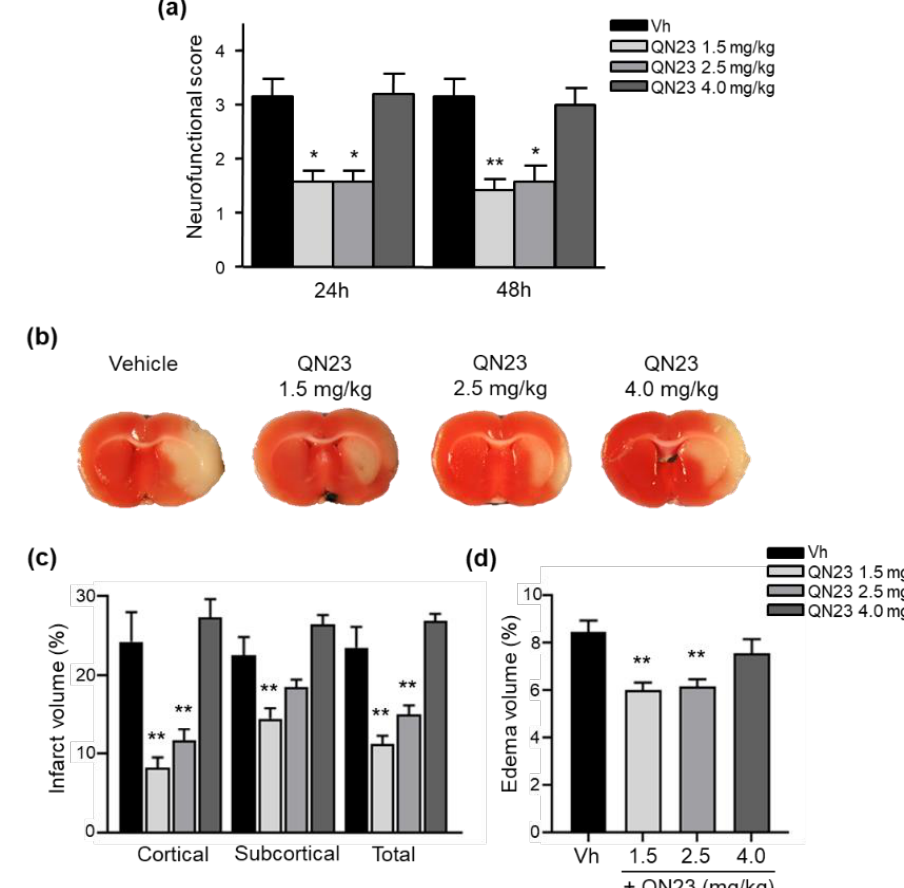
Figure 9. Cerebroprotective effects of QN23 in male Wistar rats subjected to ischemic stroke and treated with vehicle (Vh, n = 7); QN23, 1.5 mg/kg ( n = 7); QN23, 2.5 mg/kg ( n = 7); and QN23 4.0 mg/kg ( n = 5). ( a ) Neurofunctional score at 24 h and 48 h after tMCAO (transient middle cerebral artery occlusion). ( b ) Representative images of 2 mm-thick coronal sections (0.2 to − 1.8 mm from bregma) stained with 2,3,5-triphenyltetrazolium chloride (TTC) to show the infarcted (pale) area